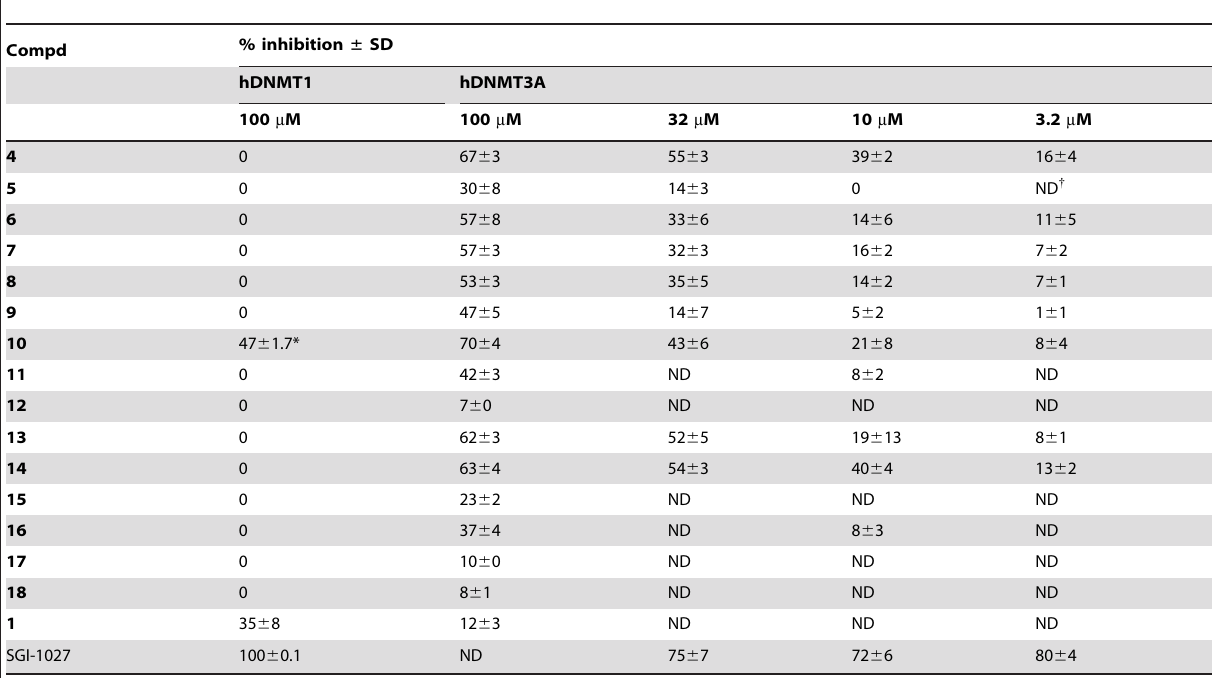
Values are means of two to five experiments 6 standard deviation. { ND, not determined. *Percent of inhibition at 32 and 10 m M: 18 6 0.8 and 6.5 6 0.7%, respectively.